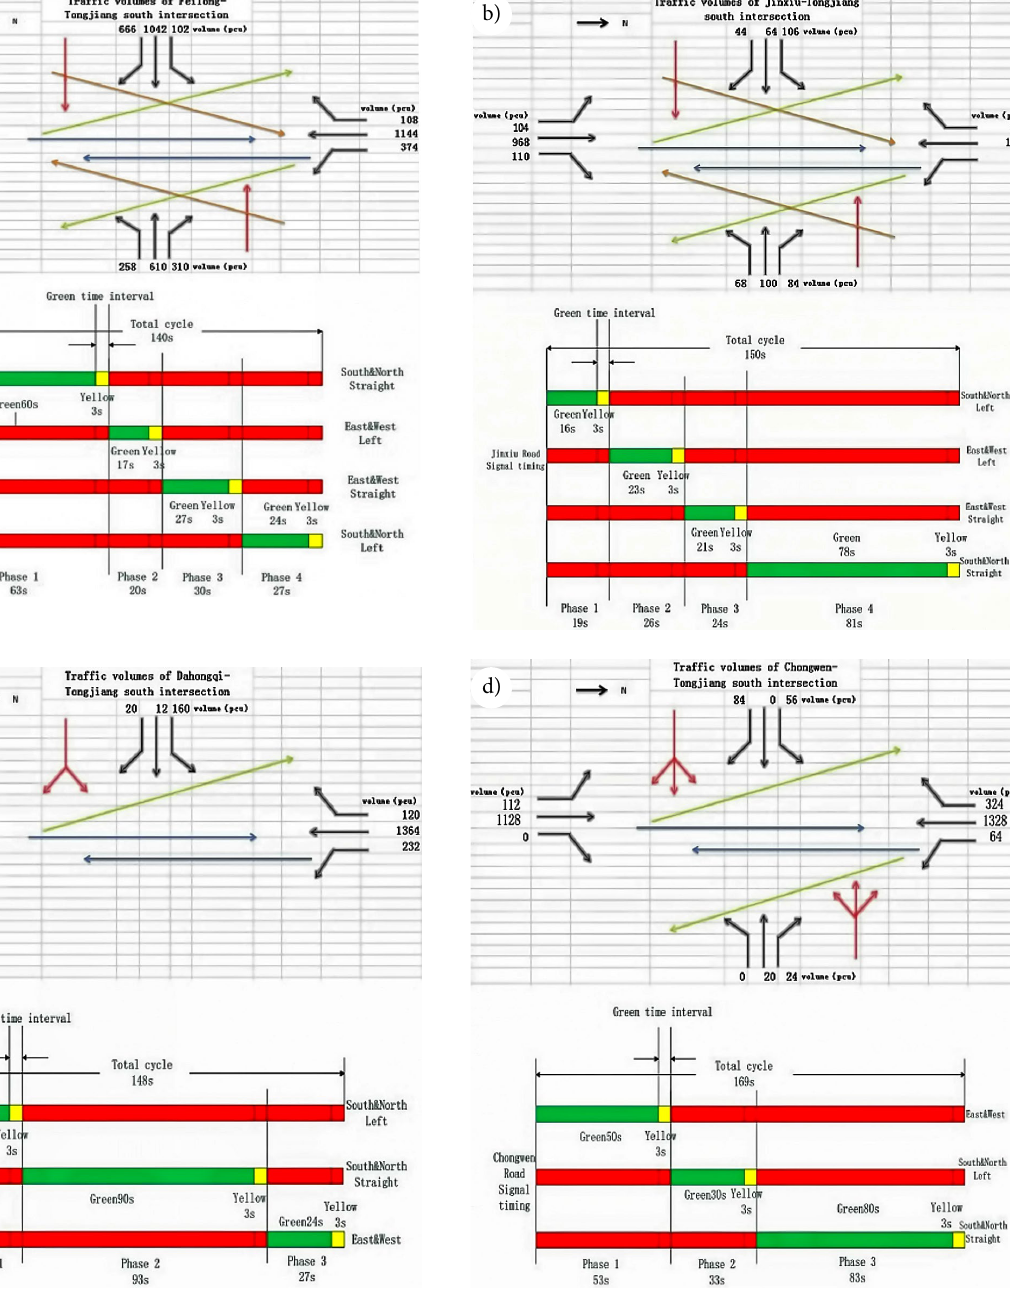
Fig. 4. Volumes and signal timings of intersections: a – Feilong road; b – Jinxiu road; c – Dahongqi road; d –